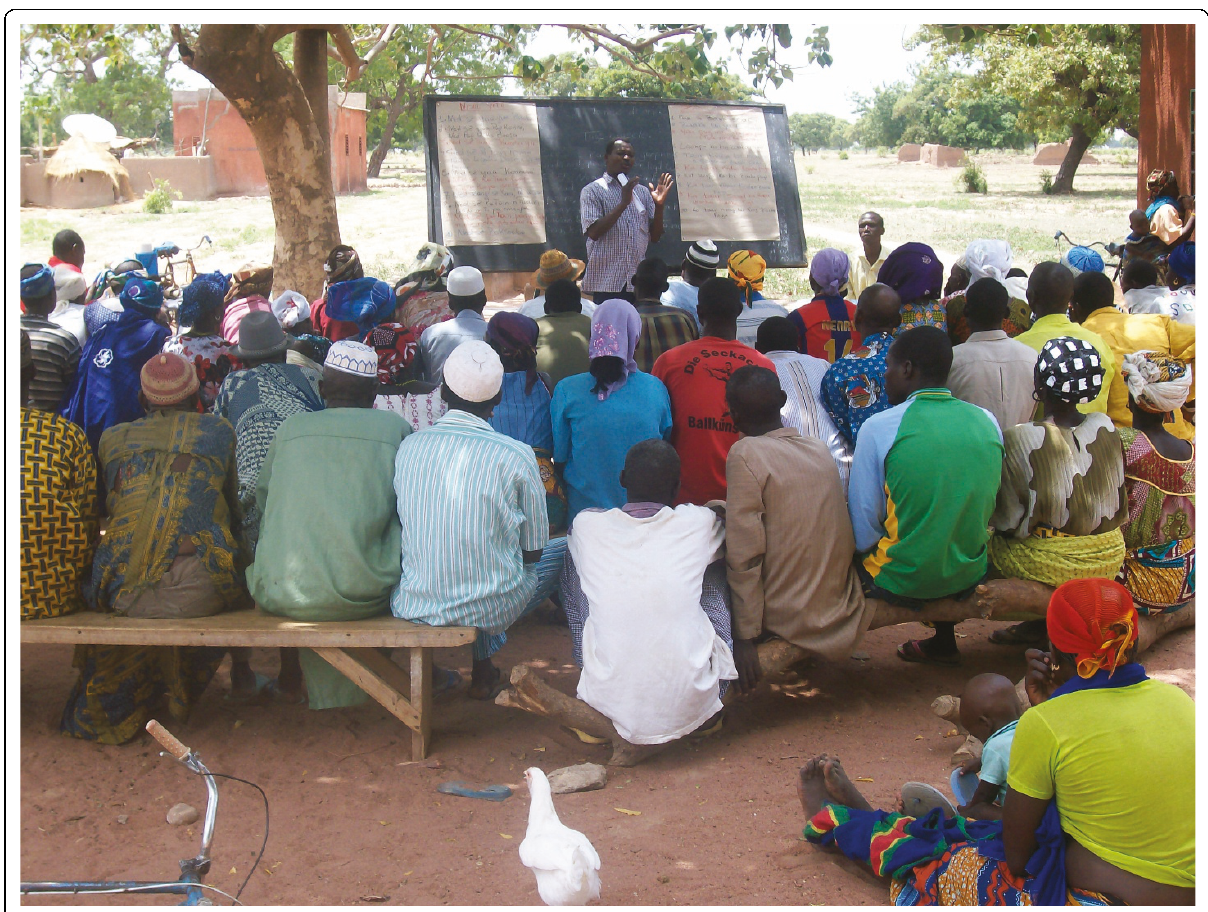
Figure 1 Community forum for presentation of results . Community forum for presentation of results conducted by a member of the Ouargaye health district team in the village of Yourga (June